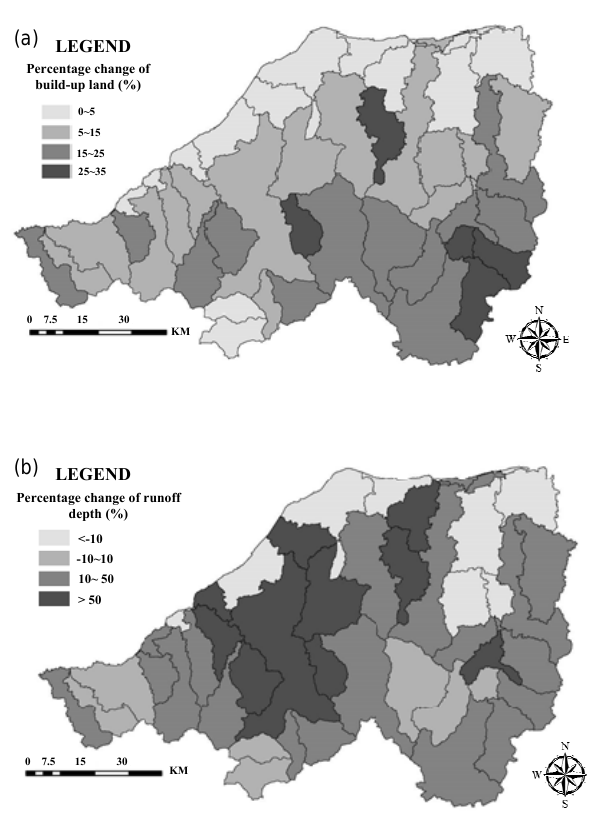
Figure 5. Percentage change of (a) build-up land proportion and (b) runoff depth at the sub-basin scale in 2008 scenario relative to 1995